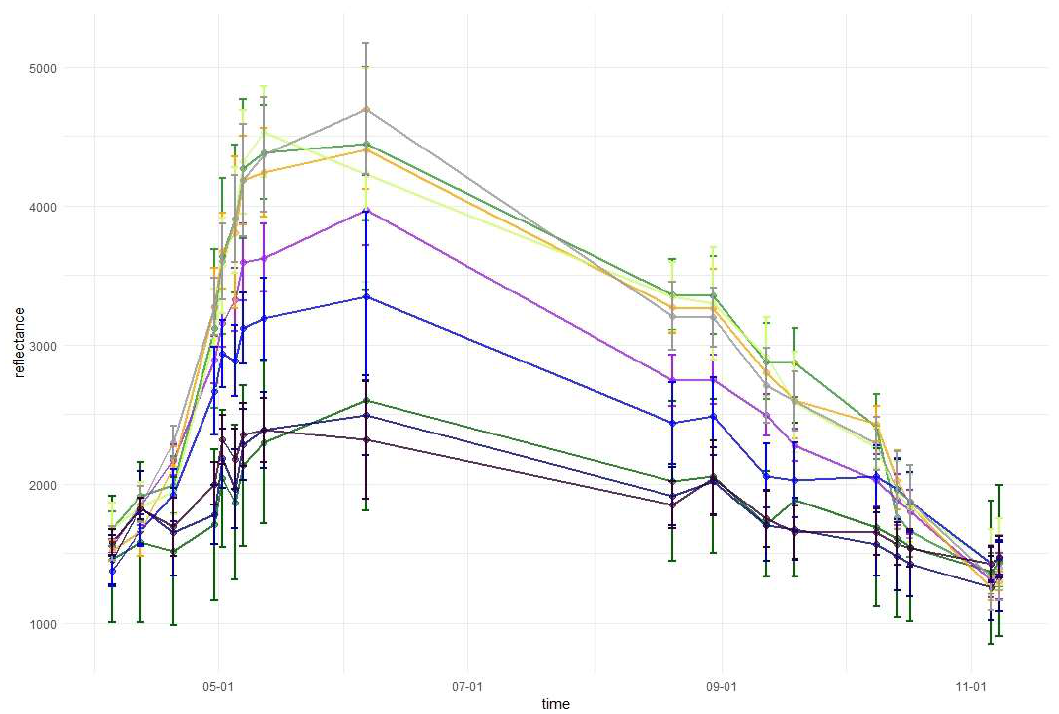
Figure A7. Mean and standard deviation values of reflectance in the near infrared 1 band.